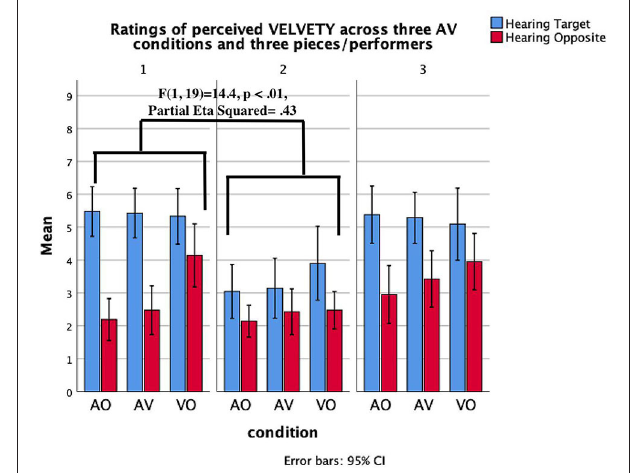
FIGURE 8 | Mean value of the evaluation of Velvety timbre across three pianists / pieces and AV stimuli. Error lines represent confidence